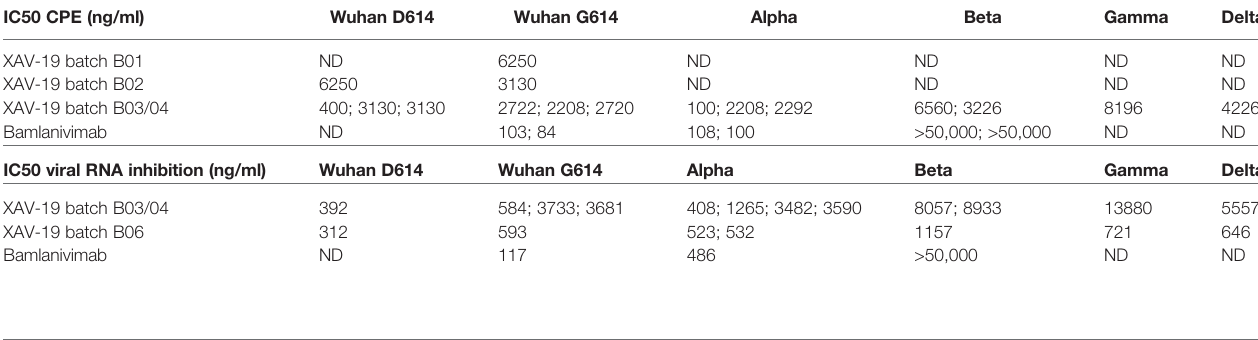
TABLE 1 | Potency assessment of XAV-19 (GMP drug substance batch B03/04) by CPE and RT-PCR quanti fi cation of residual viral RNA after infection of Vero E6 cells with virus variants.